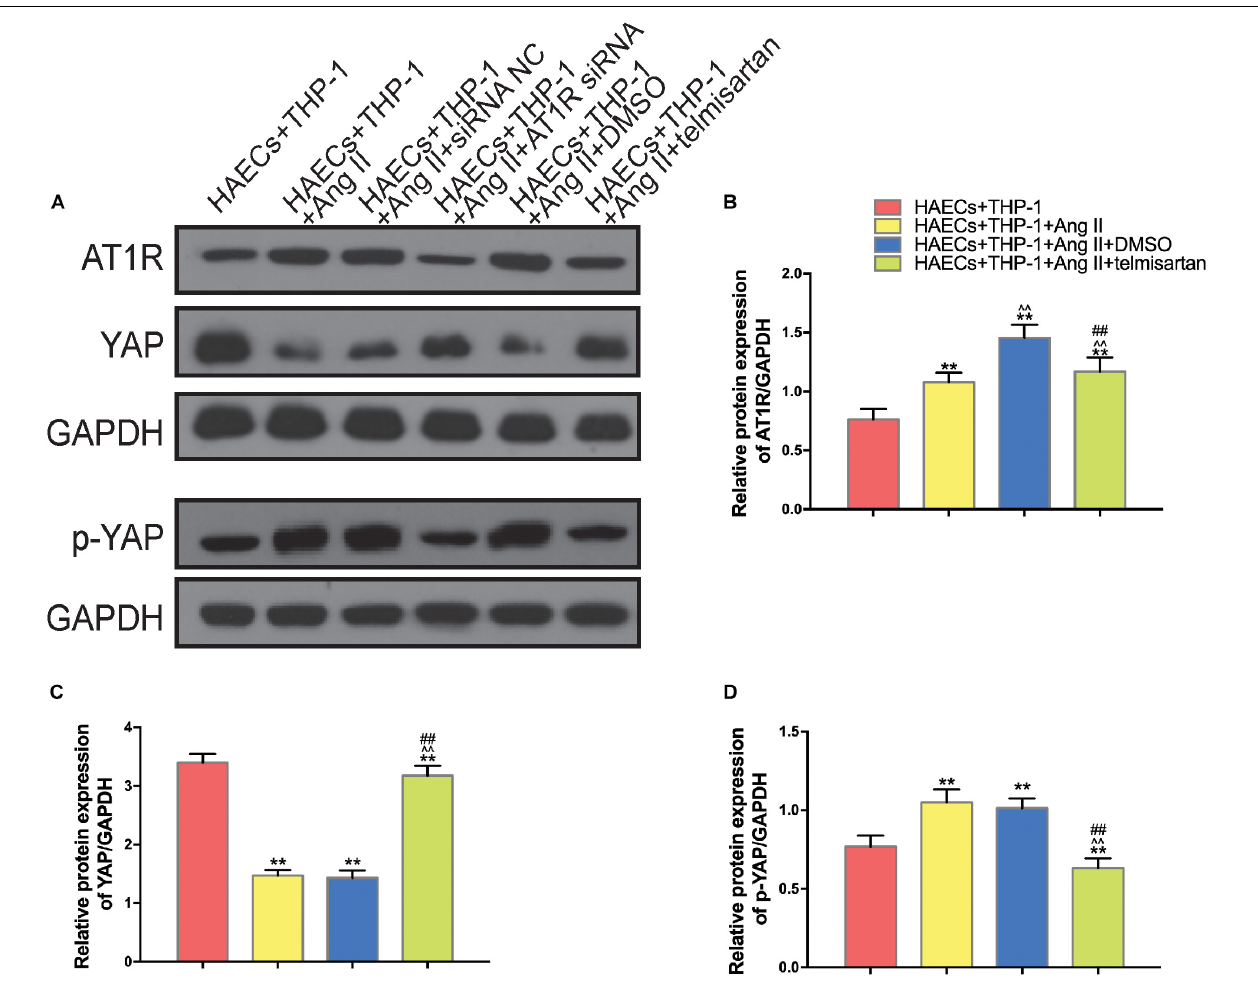
FIGURE 3 | Ang II promotes AT1R expression and YAP phosphorylation, and treatment with telmisartan or transfection with AT1R siRNA counteract this effect. (A) Western bolt analysis of six independent lysates from 96 h co-cultured HAECS + THP-1 cells that were untreated, treated with Ang II, treated with Ang II and siRNA NC, treated with Ang II and AT1R siRNA, treated with Ang II and DMSO, or treated with Ang II and telmisartan. Ang II treatment up-regulated the content of AT1R and p-YAP, and this effect was alleviated by AT1R siRNA transfection or telmisartan treatment. (B–D) The ratio between AT1R and GAPDH, YAP and GAPDH, p-YAP and GAPDH or p-YAP and YAP expression ( n = 3, mean and S.D., t -test, ** P < 0.05 compared with the HAECs + THP-1 group; ∧∧ P < 0.05 compared with the HAECs + THP-1 + Ang II group; ## P < 0.05 compared with the HAECs + THP-1 + DMSO